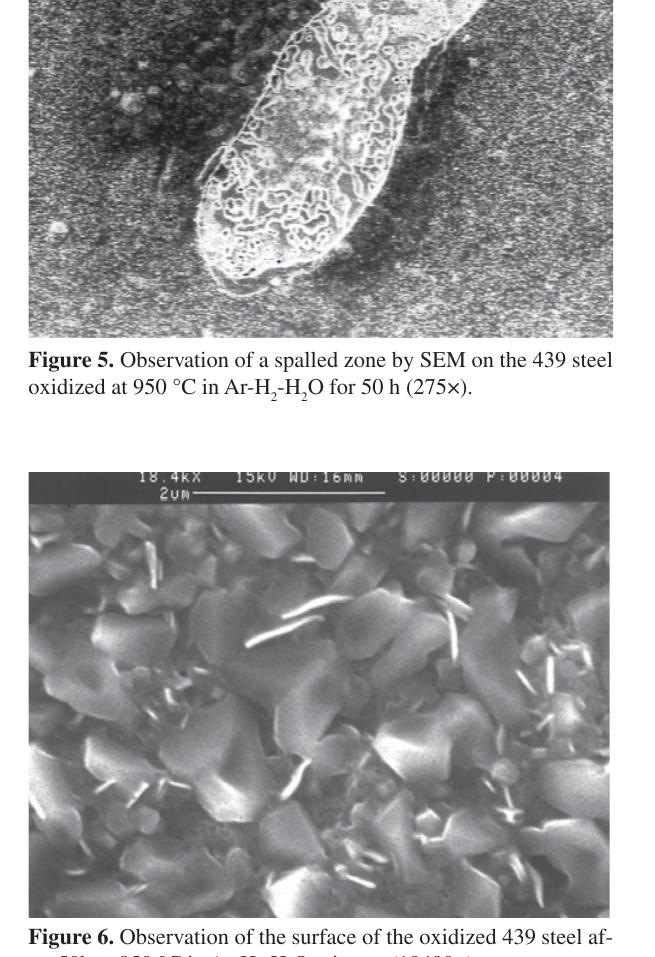
Figure 7. Observation of the surface of oxidized 304 steel. a)